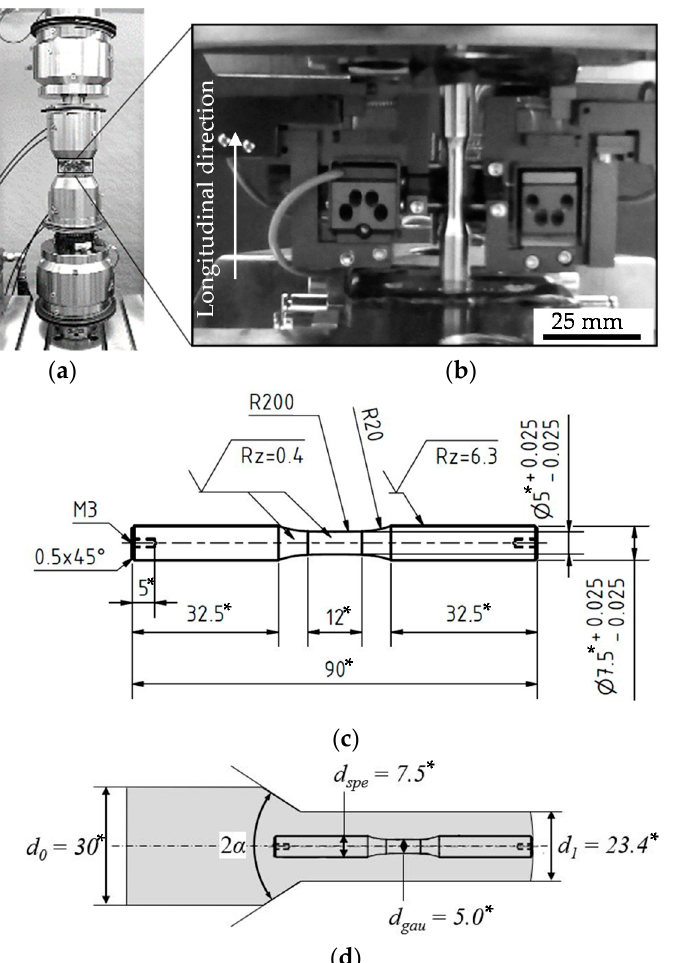
Figure 2. ( a ) Testing system Walter + Bai LFV-T250 T2500 HH; ( b ) testing set-up with specimen and axial extensometer with gauge length l gau = 10 mm used for cyclic tension ( R = 0.1) and tension–compression tests ( R = − 1); ( c ) specimen for fatigue testing at load ratios R = 0.1 and R = − 1; ( d ) Schematic visualization of extraction position. All dimensions are in